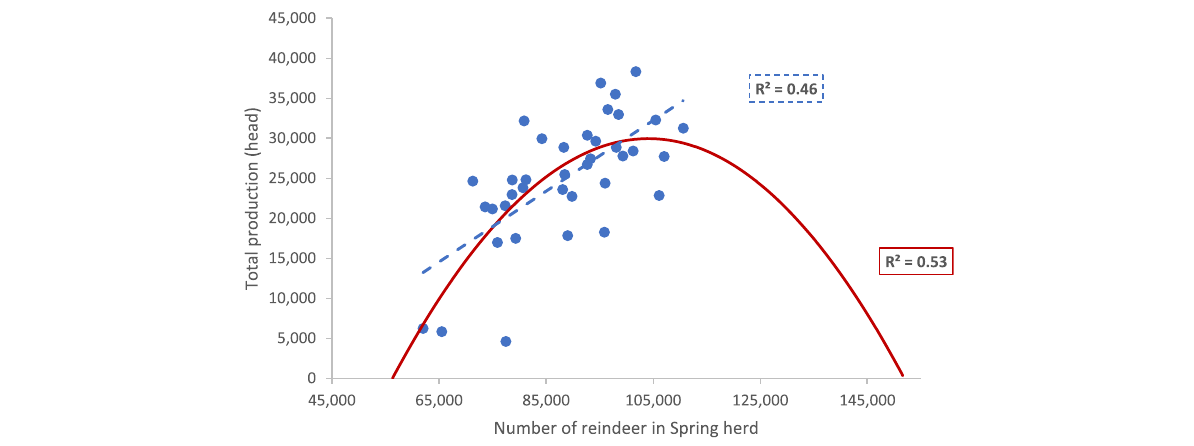
Fig. 3 Productivity in Western Finnmark, for the period 1981 – 2018, expressed as the relationship (linear in blue; polynomial in red) between the number of reindeer in the spring herd and total production (as head count) (data source: